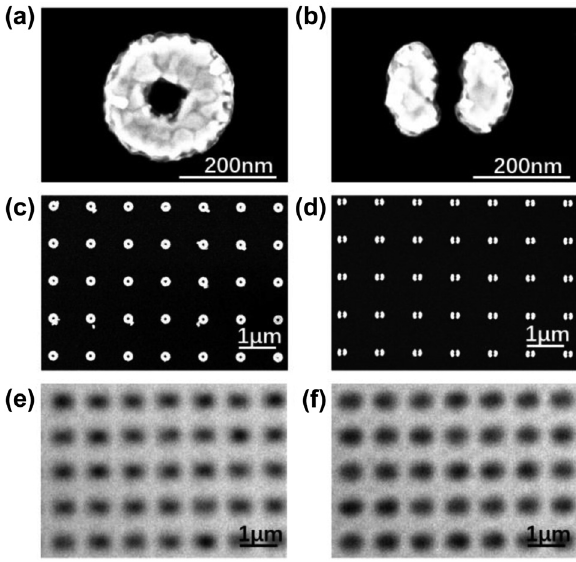
Figure 2: SEM images for ring and split-ring structures at (a)–(b) small scale and (c)–(d) large scale. Images for (e) ring and (f) split-ring structures from conventional